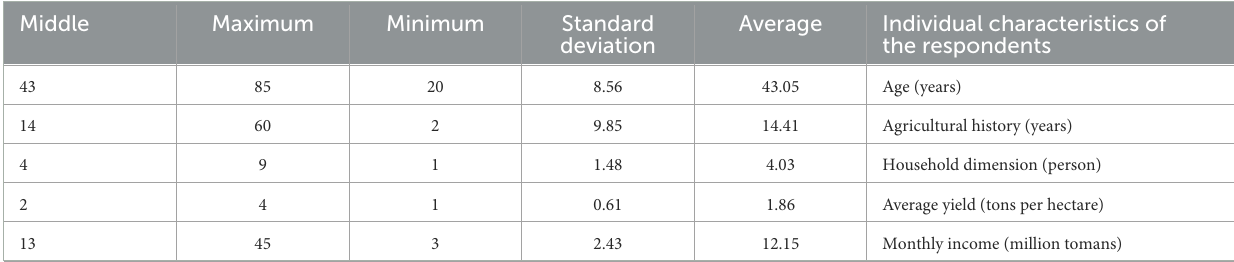
TABLE 5 Description of individual characteristics of pistachio farmers in the studied rural areas. Middle